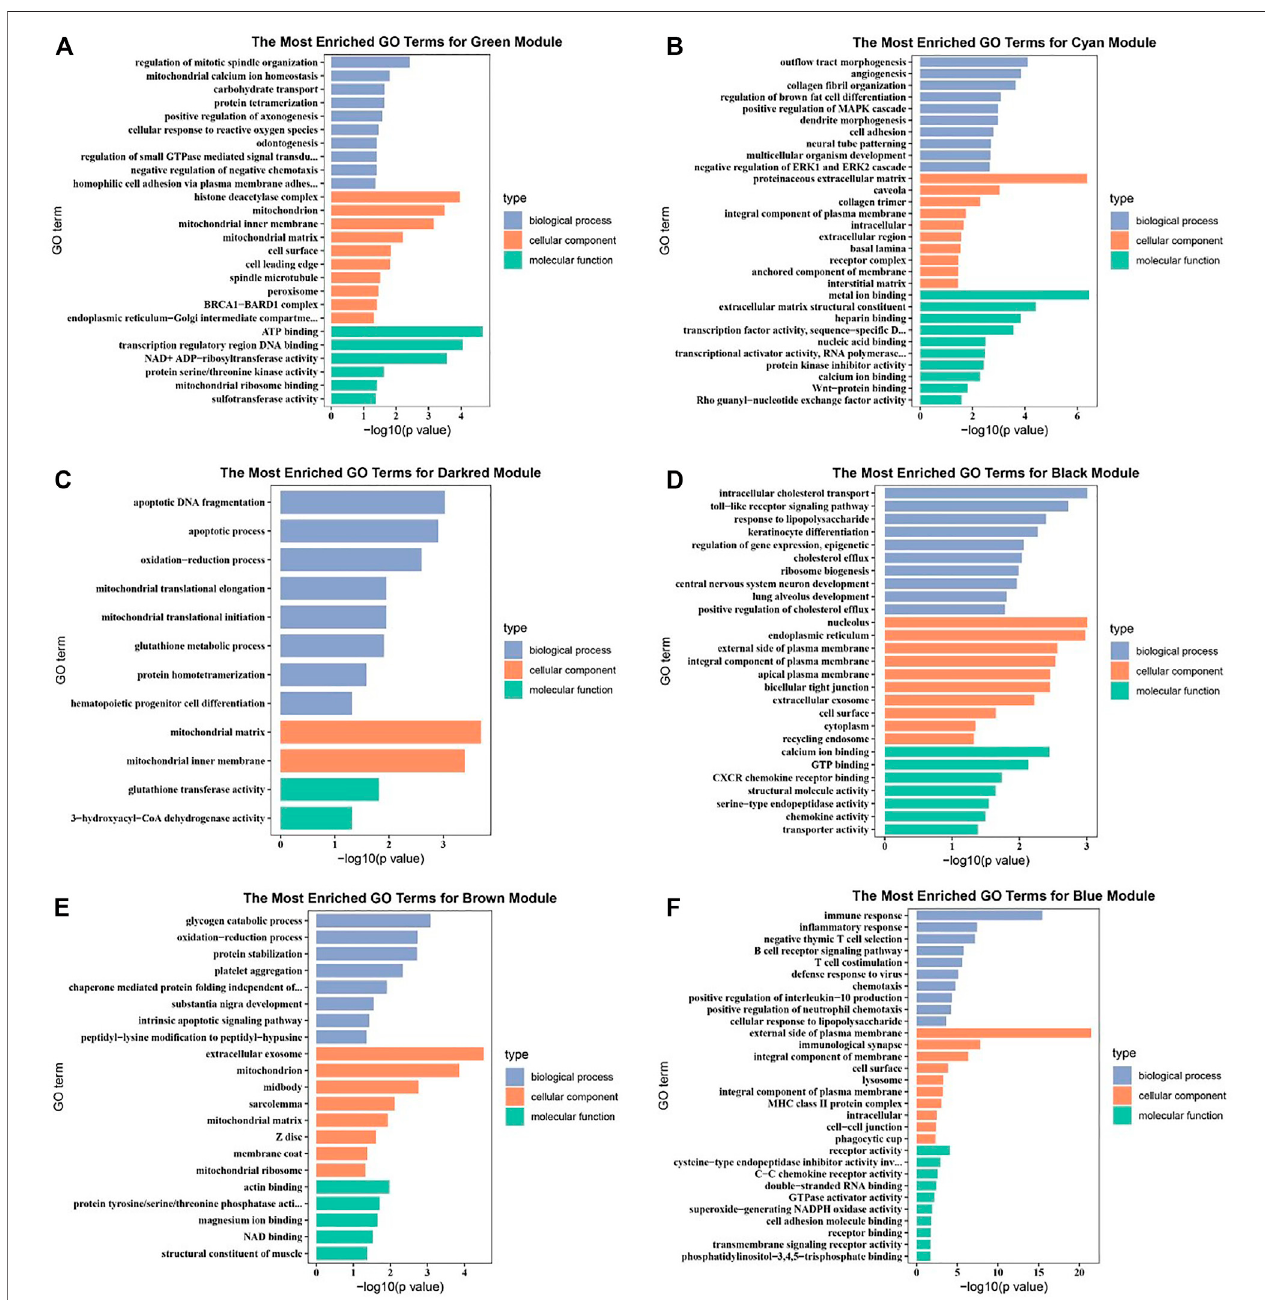
FIGURE3| Geneontology(GO)enrichmentanalysisofrelateddifferentiallyexpressedgenes(DEGs). (A) GOenrichmentanalysisofDEGsingreenmodule. (B) GO enrichment analysis of DEGs in cyan module. (C) GO enrichment analysis of DEGs in darkred module. (D) GO enrichment analysis of DEGs in black module. (E) GO enrichment analysis of DEGs in brown module. (F) GO enrichment analysis of DEGs in blue